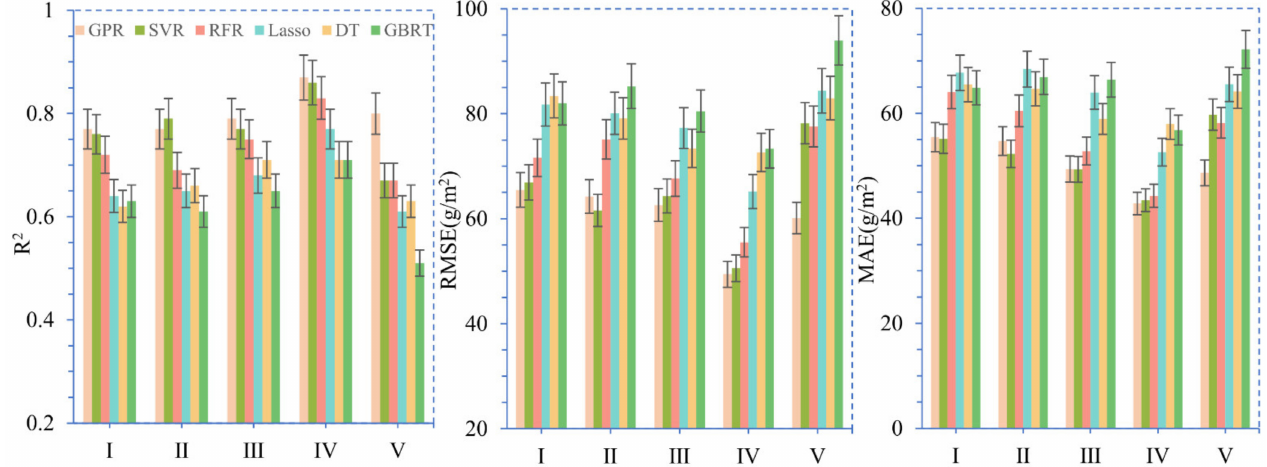
Figure 6. R 2 , RMSE and MAE of six models for winter wheat in the sampling squares at each growth stage (the unit of RMSE and MAE is g/m 2 ; I : jointing stage; II : heading stage; III : flowering stage; IV : filling stage; V : milk-ripe stage). The error bars represent the percentage error of